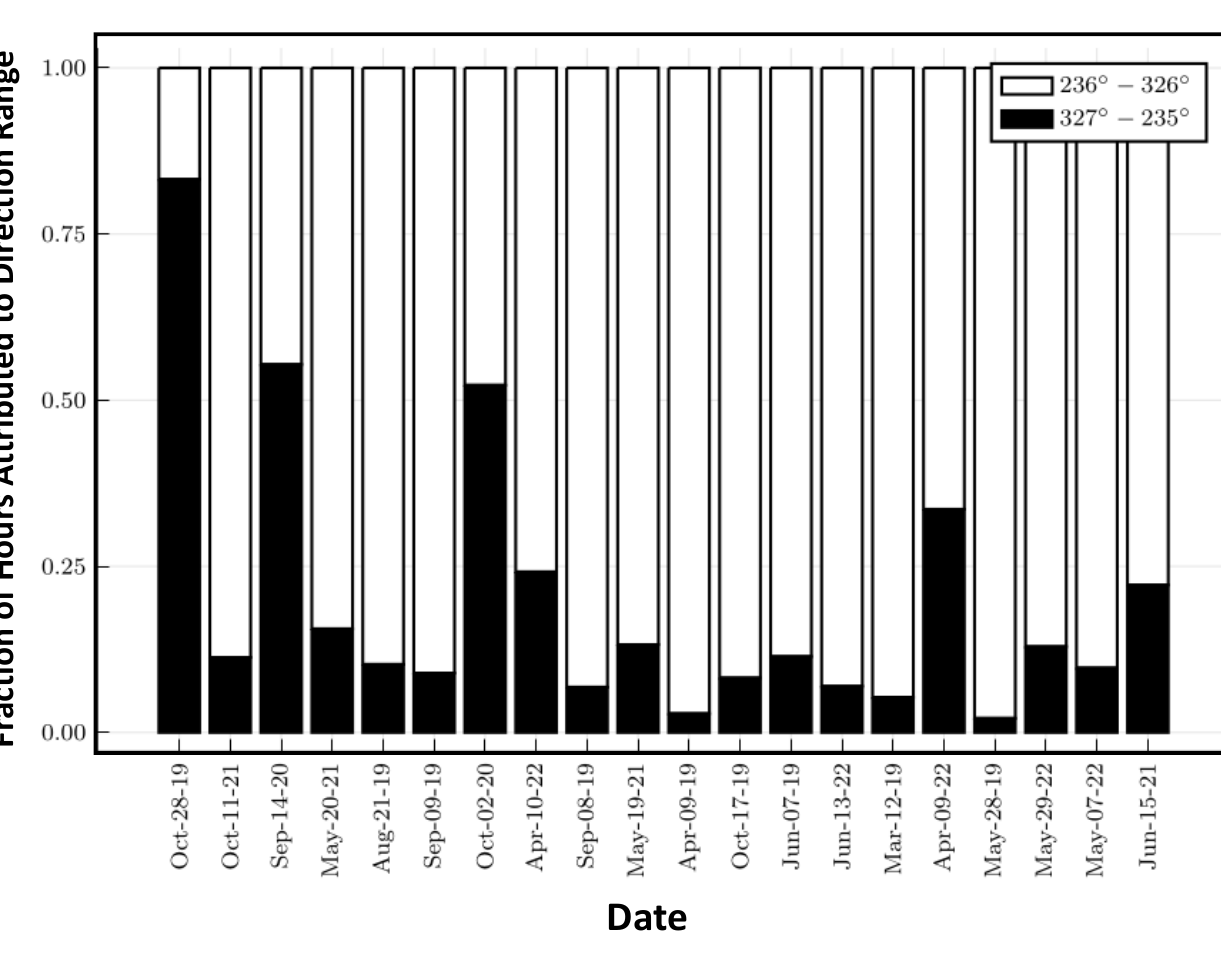
Figure 14. The fractions of the 24 h periods for the wind direction ranges of 236–326° (white portion of bar) and 327–235° (black portion of bar) for the 20 days with the highest 24 h mean PM 10 values above 50 μg m −3 , 2019–2022.